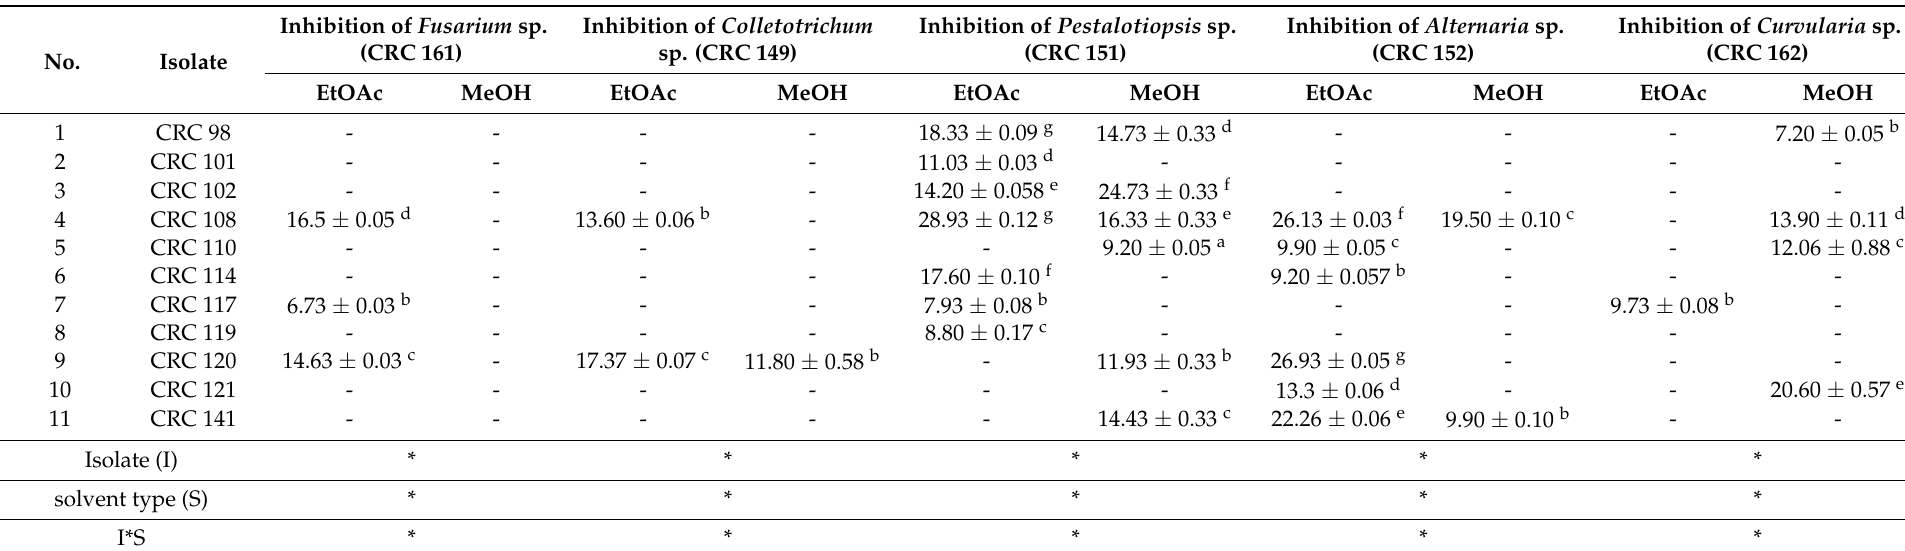
Table 3. Diameter of inhibition zone of the fungal extracts from the filtrate (EtOAc) and mycelium